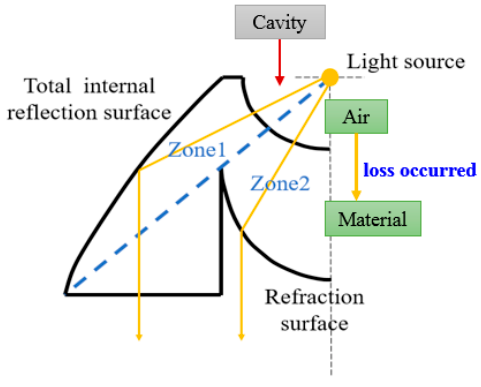
Figure 6. The process for constructing the freeform refraction surface.